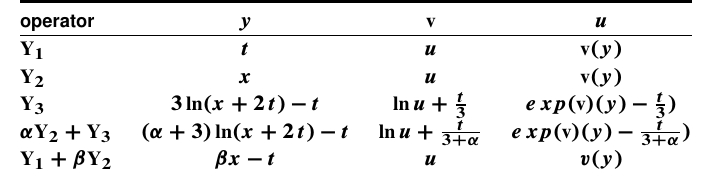
Table 7. Reduction of MBBM